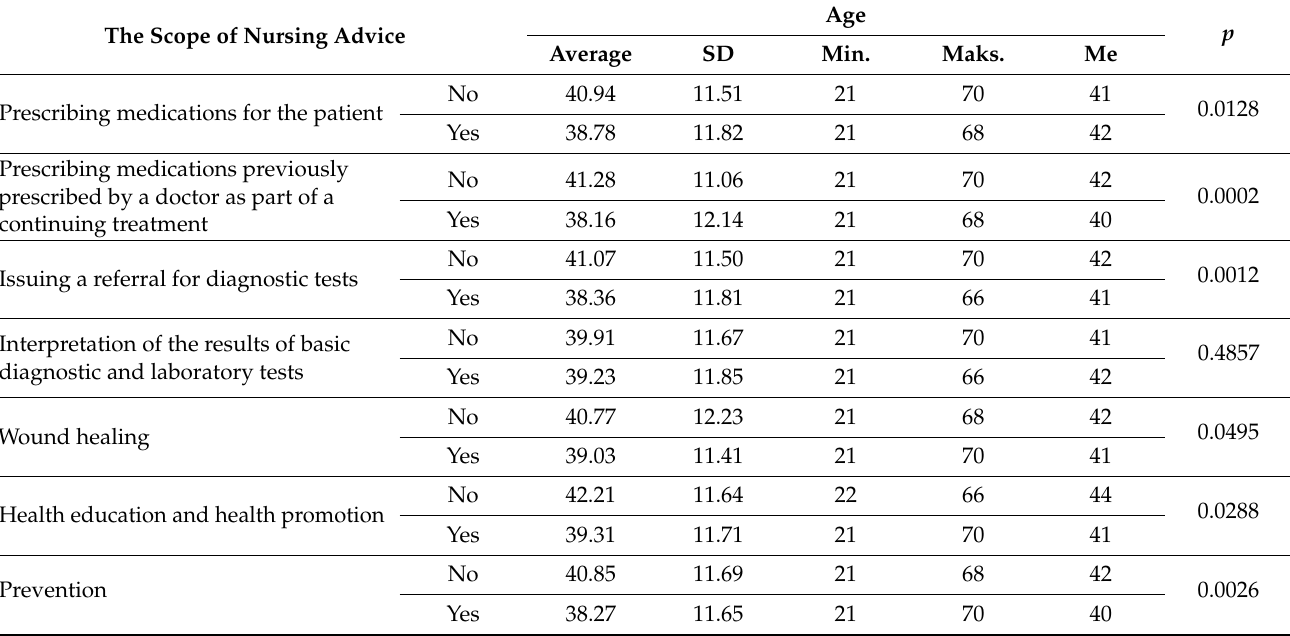
Table 3. The scope of nursing advice depending on the age of the surveyed nurses.